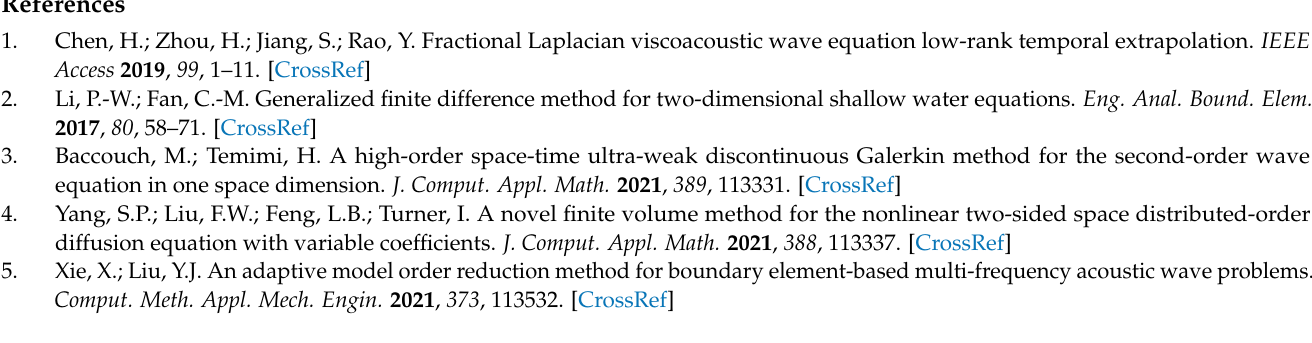
Figure 7. The numerical ( a ) and analytical ( b ) solutions with h = 0.05 and ∆ t = 0.01 for z = 0.5 at 1 t = .